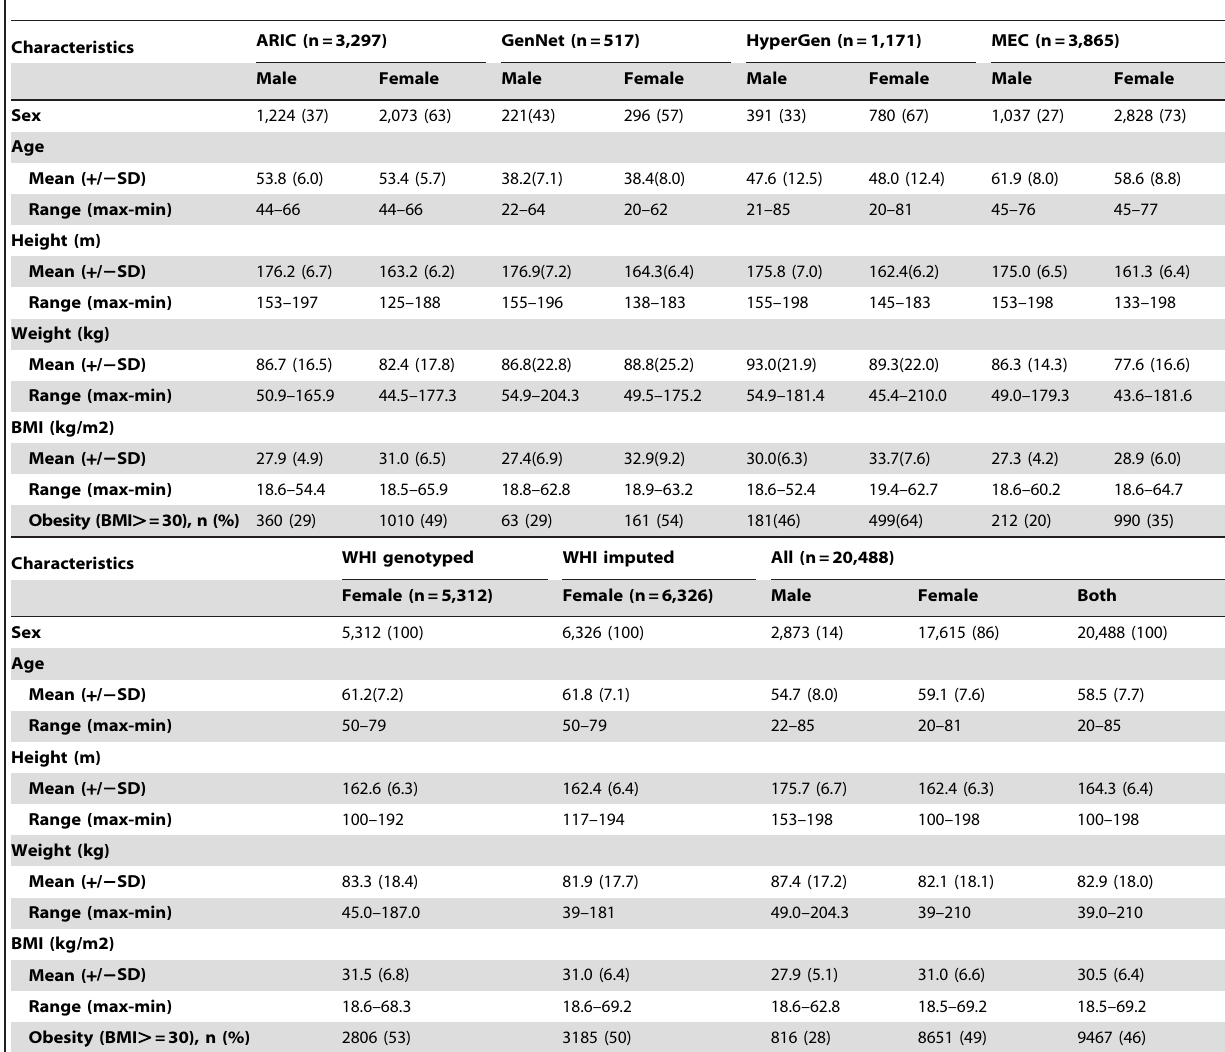
Table 1. Distribution of study characteristics by study and